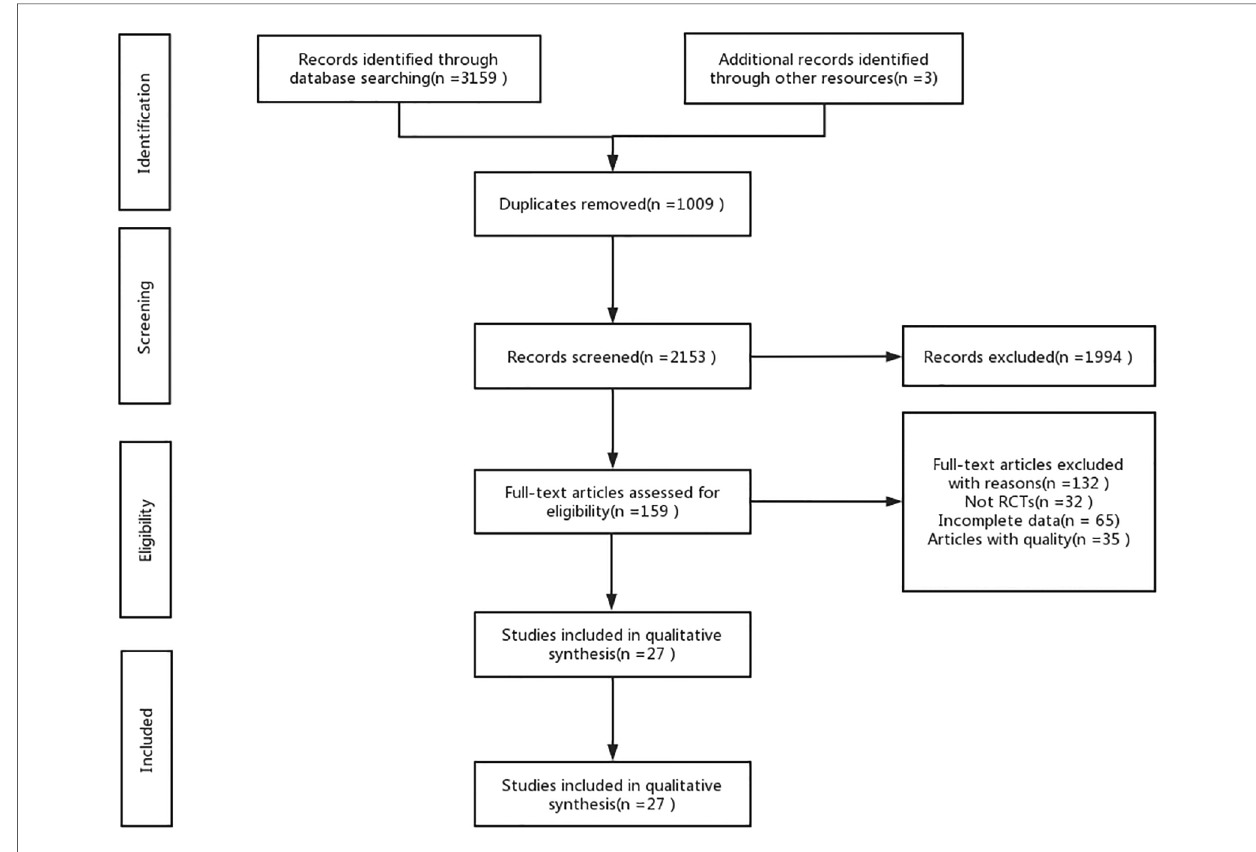
FIGURE 1 Flow diagram of literature